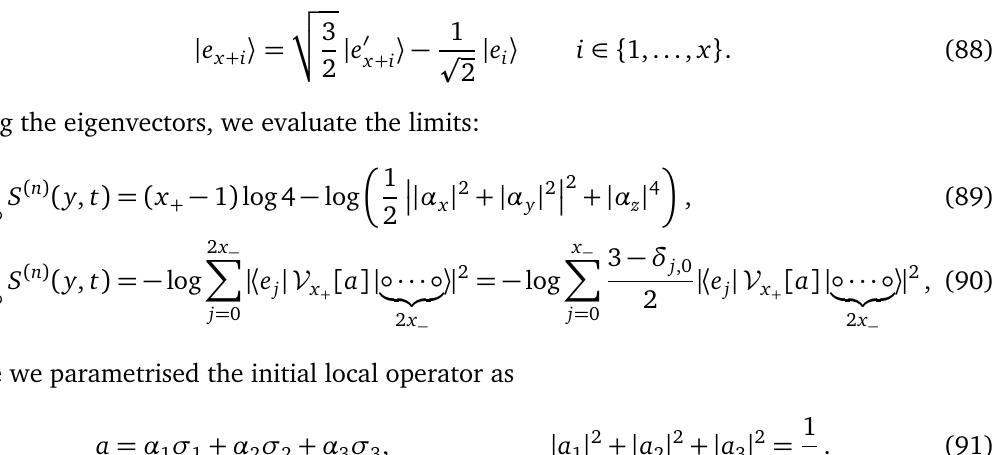
π , k ∈ (cid:90) , where 4 , a are the same 1 2